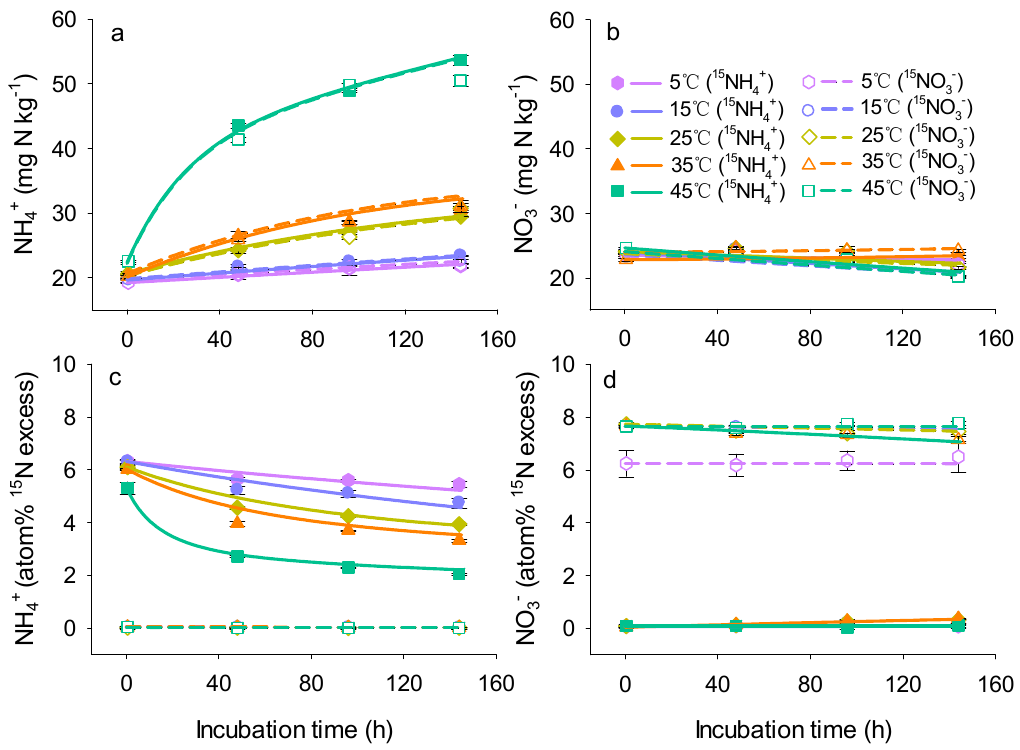
Figure 1. Measured ( symbols ) and modeled ( lines ) concentrations of NH 4+ ( a ) and NO 3 − ( b ), and 15 N enrichments of NH 4+ ( c ) and NO 3 − ( d ). Vertical bars indicate standard deviations of the mean value.